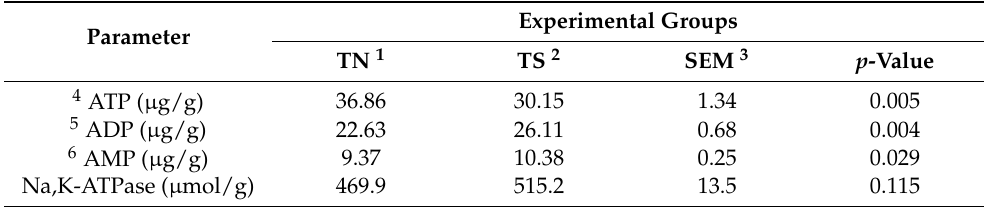
Table 4. Effect of chronic thermal stress on energy biomarkers in liver tissues of broiler chickens. Parameter